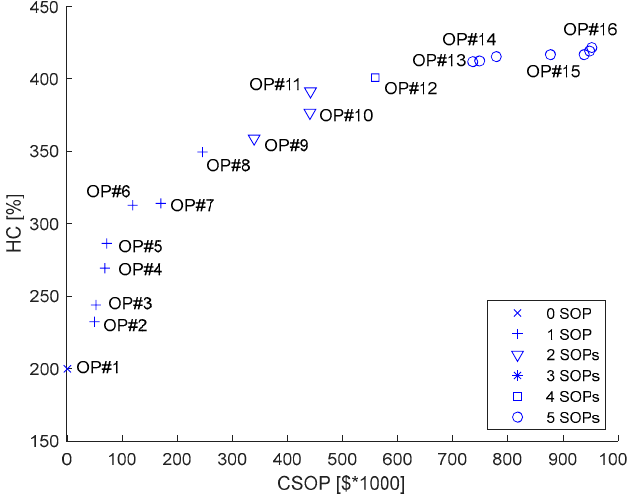
Figure 11. Pareto front of Case 3.